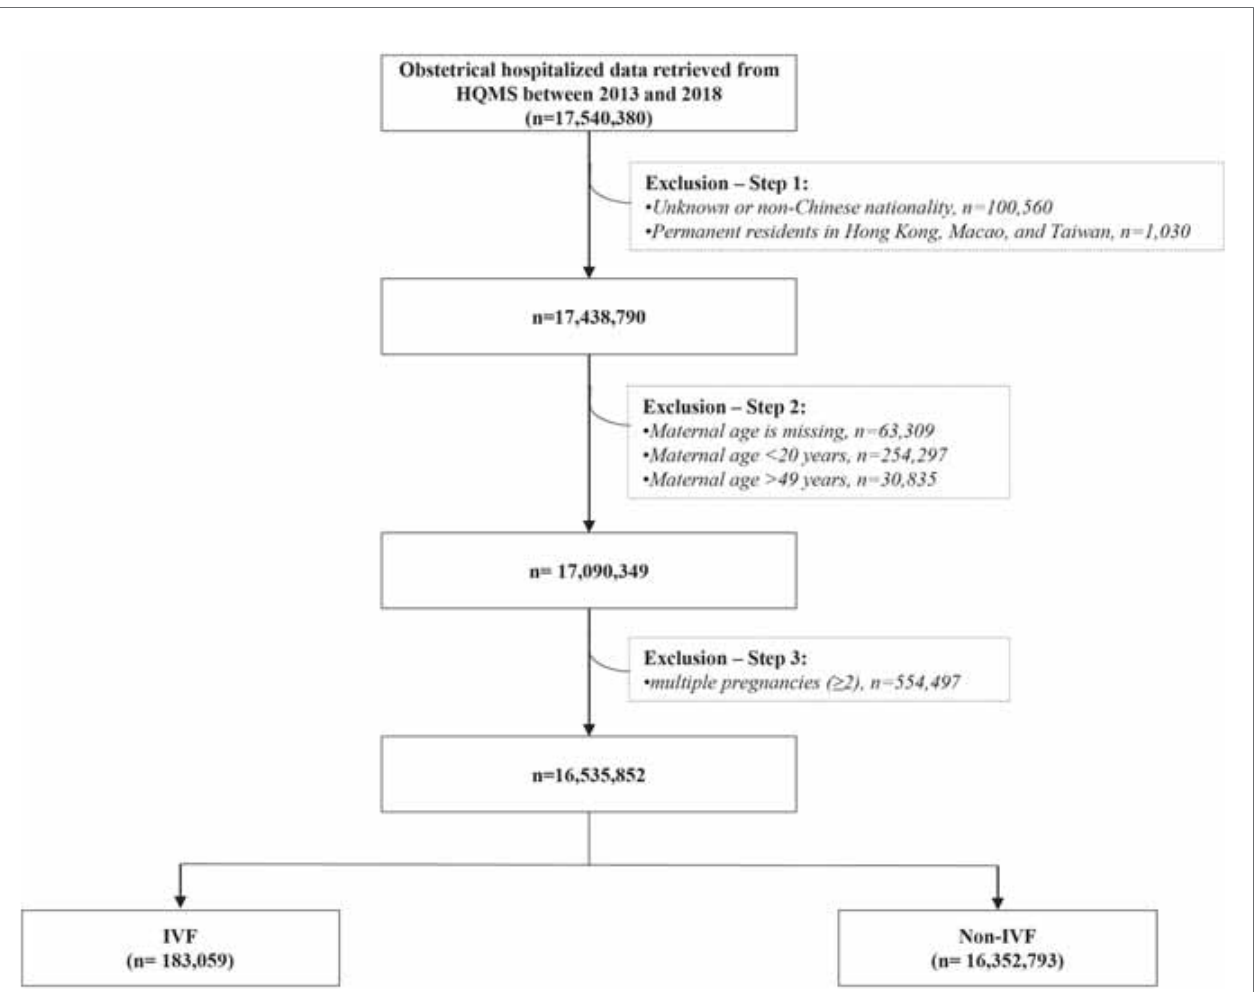
FIGURE 1 | The fl owchart of eligible study population in this study IVF, in vitro fertilization; Non-IVF, non- in vitro